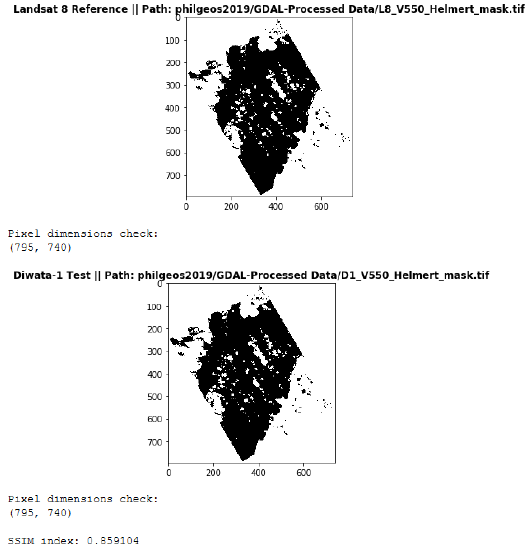
Figure 2. Screenshot of the output of the prepared code for SSIM implementation on Diwata-1 SMI V550 image of Sofronio, Palawan, warped via Helmert